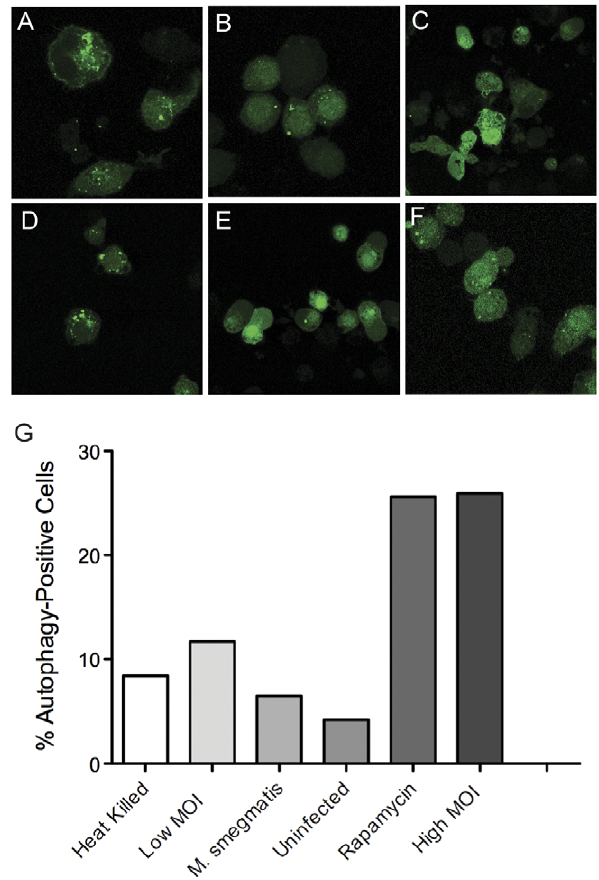
Figure 6. High intracellular burden of M.tb induces LC3 aggregation. GFP-LC3 expressing macrophages were infected with bacteria for 6 h as indicated below or treated with rapamycin before being fixed and examined by confocal microscopy for aggregation of LC3 indicative of autophagy. Conditions included ( A ) viable M.tb Erdman (MOI 50), ( B ) viable M.tb Erdman (MOI 10), ( C ) viable M. smegmatis (MOI 50), ( D ) rapamycin (25 m g/ml, 3 h), ( E ) heat-killed M.tb Erdman (MOI 50), and ( F ) no infection. Viable M.tb Edrman at MOI 50 induced LC3 aggregation as strongly as the positive control, rapamycin. Viable M.tb Edrman at MOI 10, viable M. smegmatis and heat-killed M.tb Erdman did not increase LC3 aggregation compared above the level in uninfected macrophages ( F ). ( G ) The induction of autophagy was quantified by counting the % cells in each group with a number of LC3 aggregates above the median basal level of 5, found in untreated, uninfected macrophages.